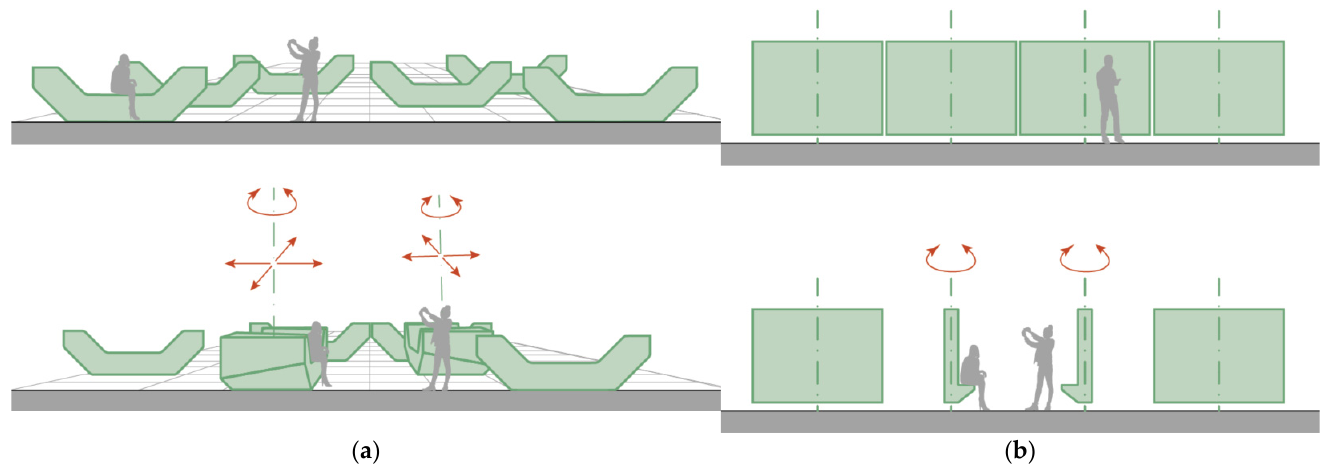
Figure 1. ( a ) Sketches presenting the space with movable Vienna modules, MuseumsQuartier, Vienna. ( b ) Possibilities for the placement of rotating panels that form part of the fence in the LentSpace area, NYC.